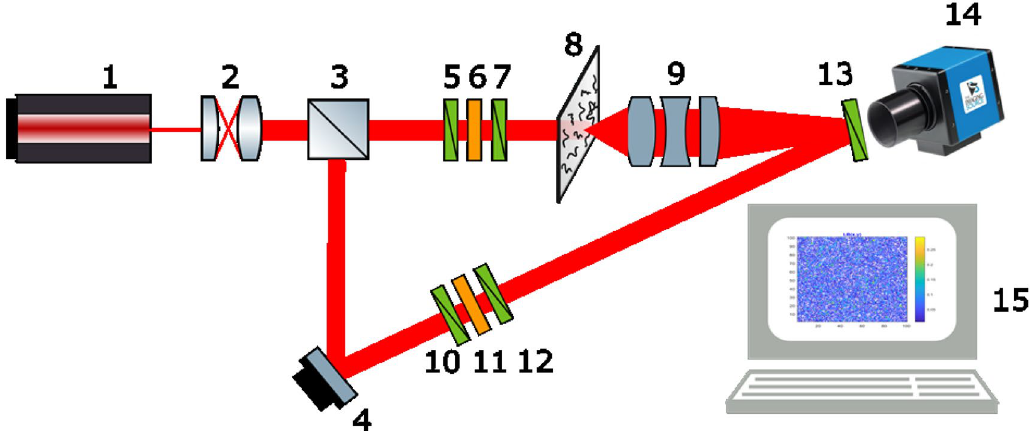
Figure 1. Optical scheme of a 3D Mueller matrix polarimetry setup, consisting of: 1—laser; 2—collimator; 3—beam splitter; 4—reflecting mirror; 5, 7, 10, 12, 13—polarisers; 6,11—quarter-wave plates; 8—object under investigation; 9—strain-free polarisation objective; 14—digital camera; 15—processing